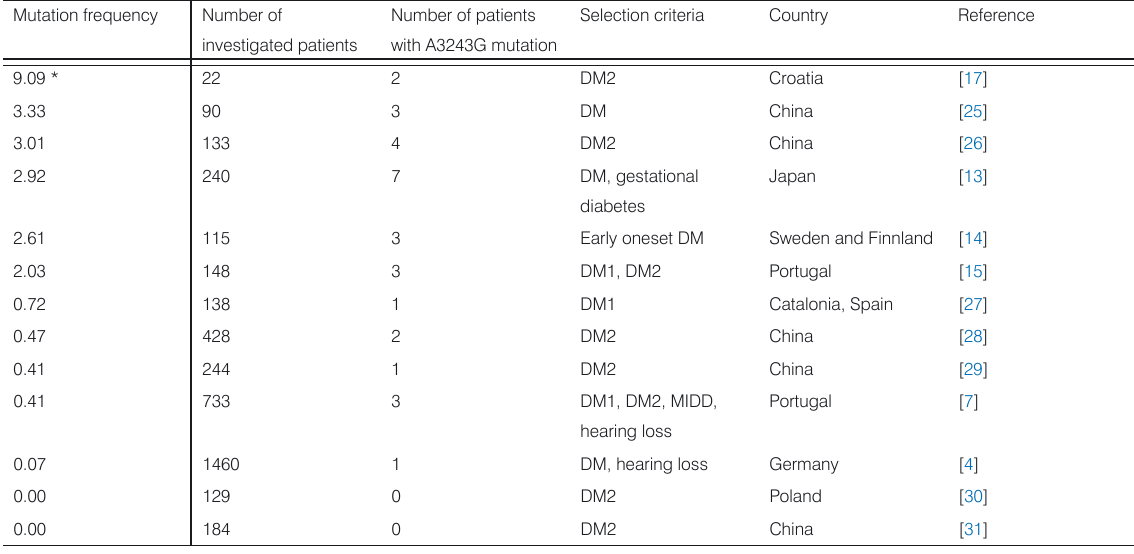
Table 2. The mtDNA A3243G mutation frequencies among the patients with diabetes mellitus in different countries (* Pilot study with oral mucosal DNA samples). Mutation frequency